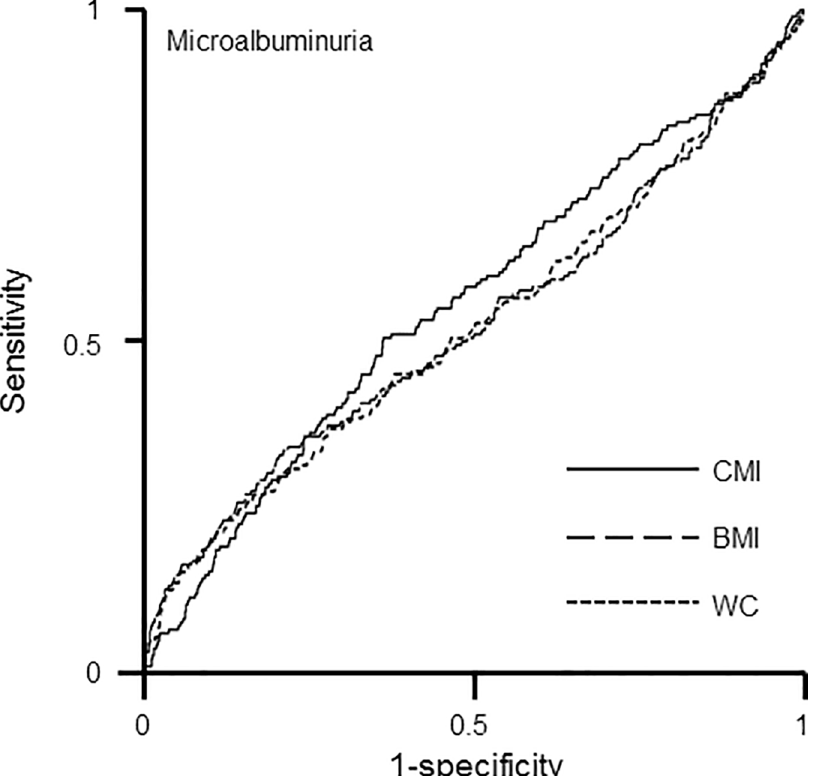
Fig 1. Receiver-operating characteristic (ROC) curves representing the prediction capacity of risk for (B) microalbuminuria. Comparedwith WC (AUC * = 0.5199, 95% CI * = 0.4716–0.5681), CMI (AUC * = 0.5523, 95% CI * = 0.5069–0.5977, P * = 0.0662) and BMI (AUC * = 0.5223, 95% CI * = 0.4732–0.5713, P * = 0.6369) have better precisionin predictingmicroalbuminuria, but the difference was not statistically significant.BMI; body mass index; WC, waist circumference; AUC, area under the curve; CI , confidence interval. * calculated by logistic regressionanalysisusing age, sex, systolic BP, and diastolicBP as covariates.